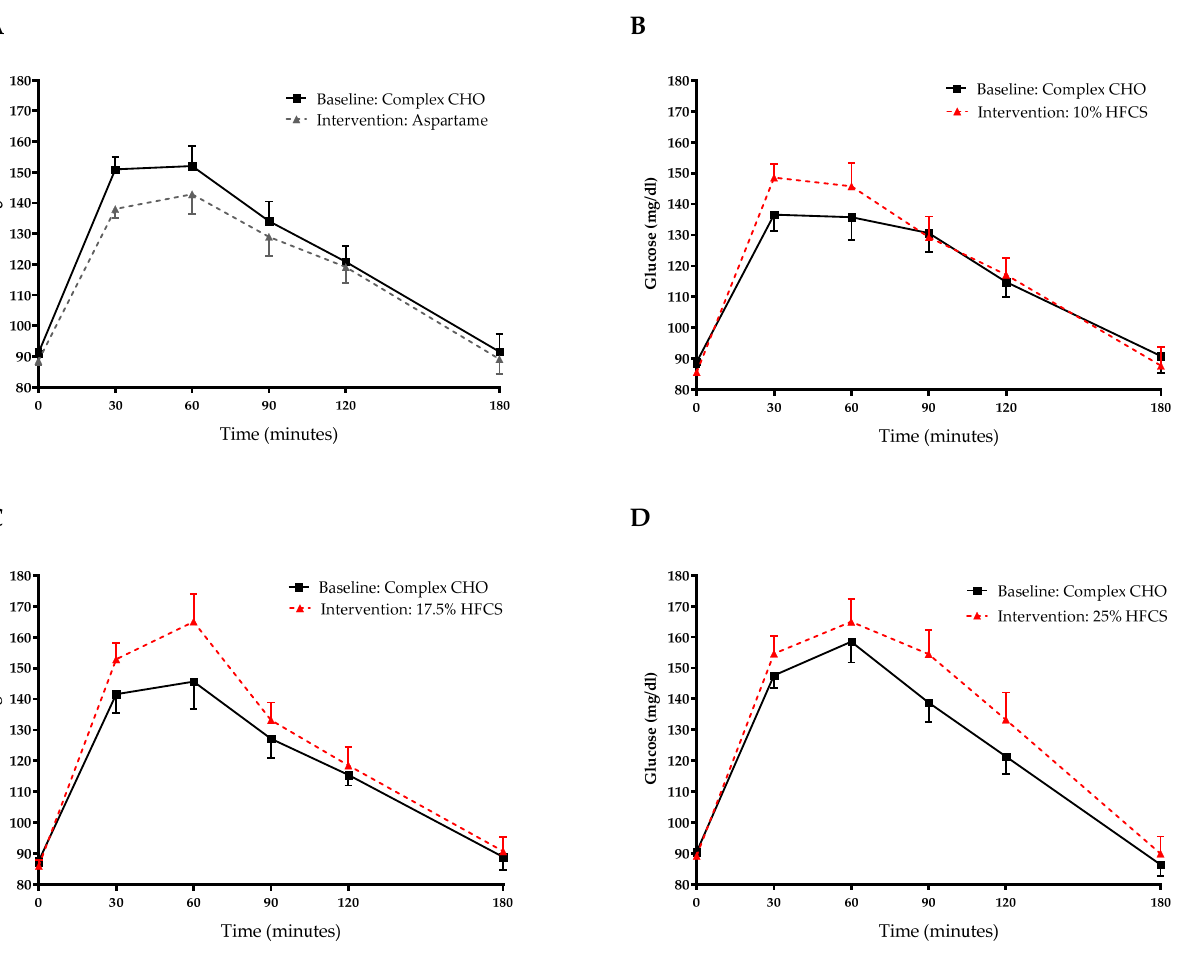
Figure 5. Plasma glucose excursions during 3-h OGTT: Glucose concentrations during OGTT at baseline and after consuming 0 ( n = 23) ( A ), 10 ( n = 18) ( B ), 17.5 ( n = 15) ( C ), or 25% ( n = 28) ( D ) HFCS-sweetened beverages for the two-week intervention. CHO, carbohydrate; HFCS, high-fructose corn syrup.